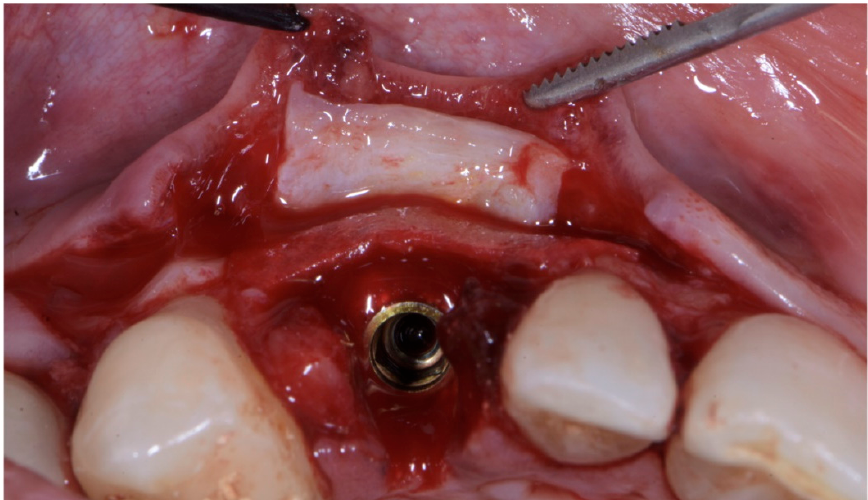
Figure 9. Connective-tissue graft sutured in inner aspect of buccal flap, 1 mm apical with respect to mucosal margin, with two horizontal internal mattress sutures.